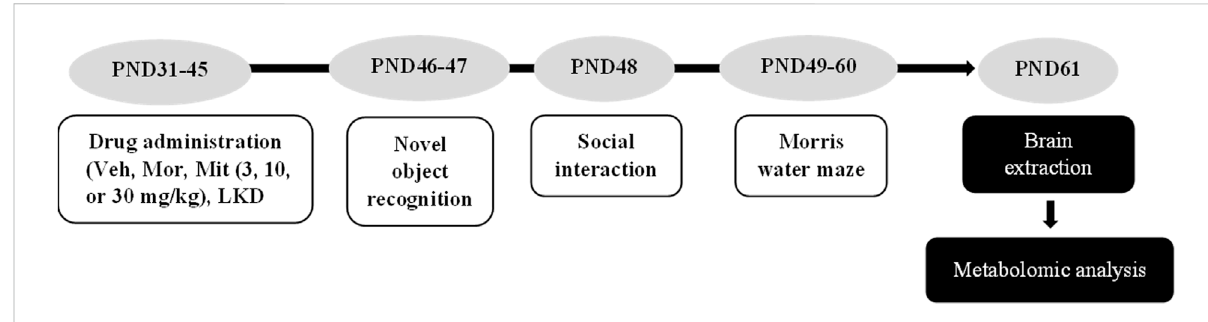
FIGURE 1 Drug administration, behavioural testing, and metabolomic analysis